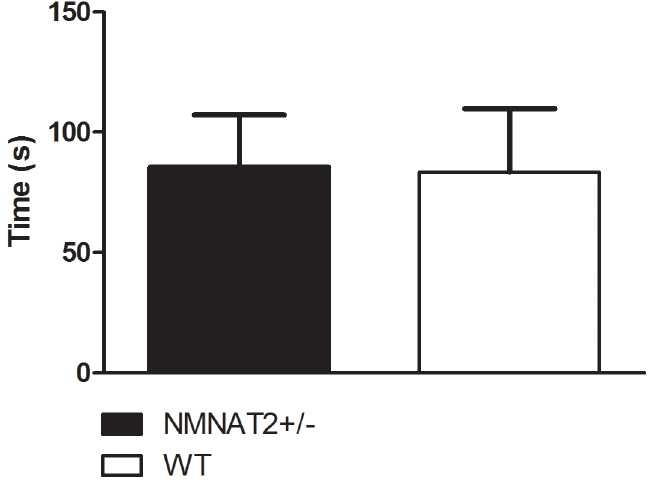
Fig 3. Latency to descend from the rotatrod did not differ between NMNAT2+/- and WT mice. Data are expressed as mean ± SEM (NMNAT2 +/- n = 16, WT n = 10). * p < .05 vs. vehicle, one-way analysis of variance followed by Bonferroni post hoc test.